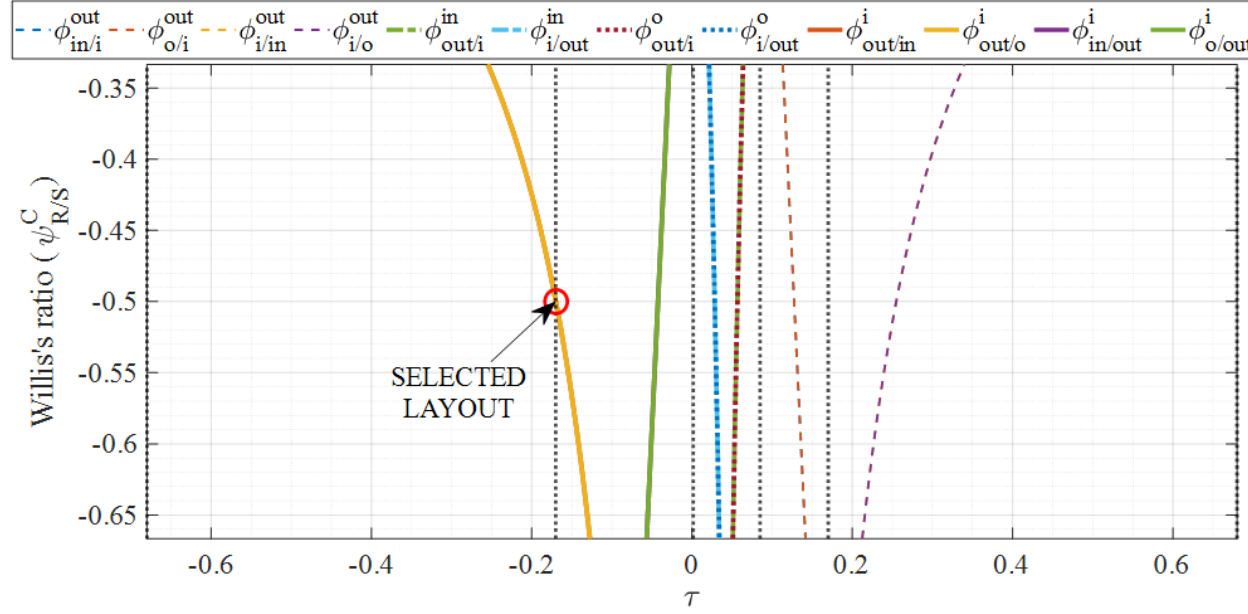
Figure 7. Design chart for PG synthesis and selected layout with ICE working at 1400 rpm and 2080 Nm.